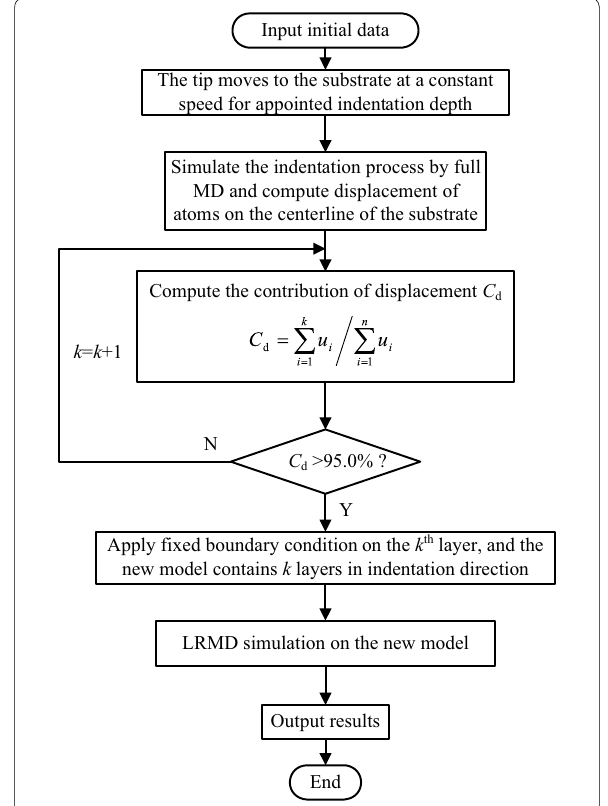
Figure 2 Flowchart for LRMD simulation method